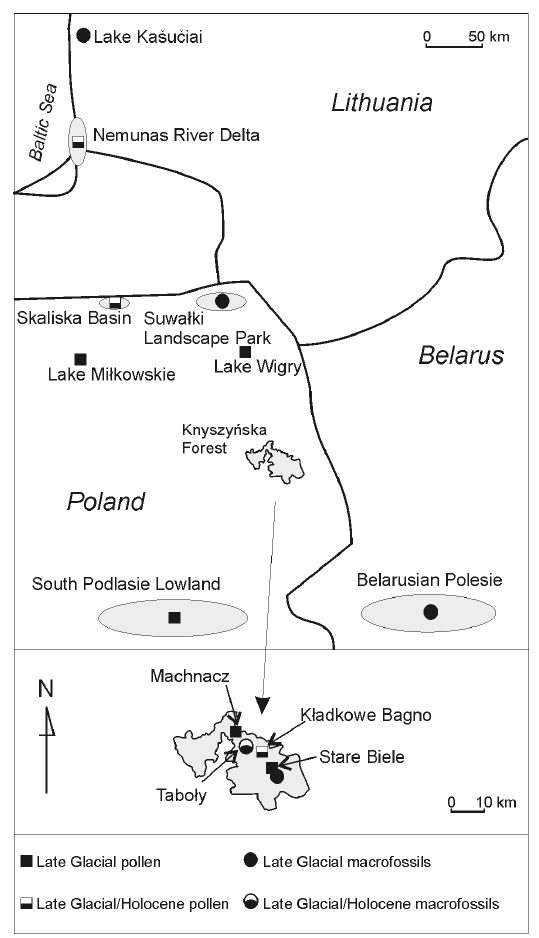
Fig. 2. Location of sites with Betula nana pollen and macro- fossils recognized in Late Glacial and Holocene sediments of northeastern